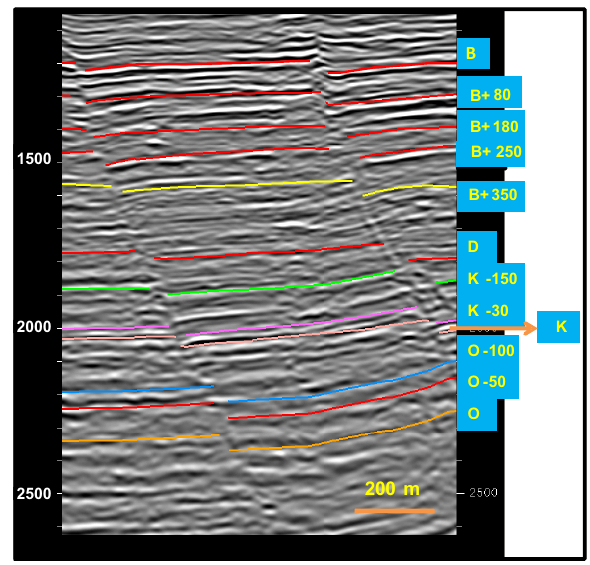
Fig. 3 Selected horizons for seismic geomorphology